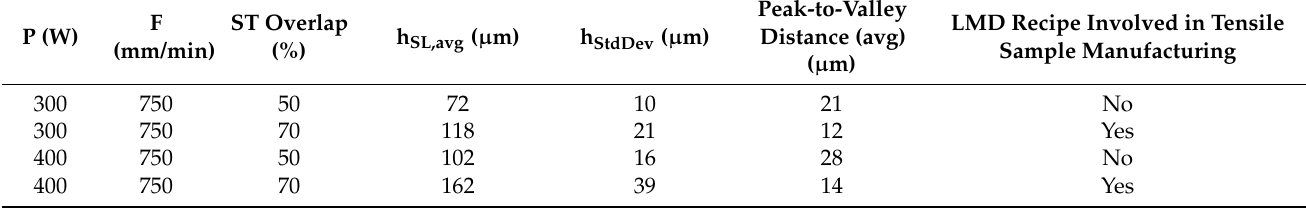
Table 4. Detected SL height at different LMD combination of process parameters.